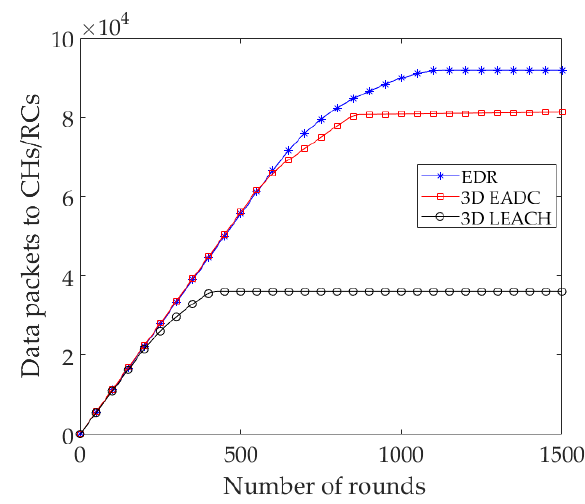
Figure 5. Number of local data packets sent to CH/RC nodes.